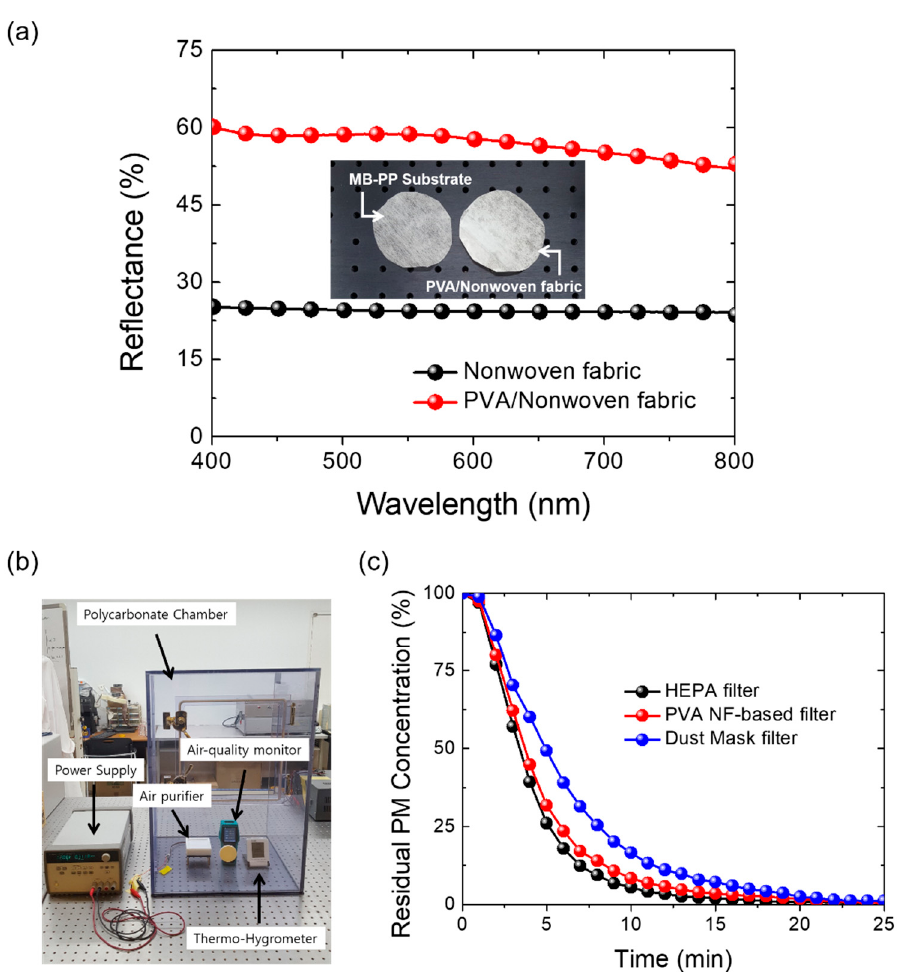
Figure 2. ( a ) Reflectance spectrum of nonwoven fabric and poly(vinyl alcohol) nanofiber (PVA NF)-based filter; ( b ) photograph of the device for the PM removal performance test in polycarbonate chamber; ( c ) comparison of the chamber test results of commercial nonwoven fabric- and PVA NF-based filters.